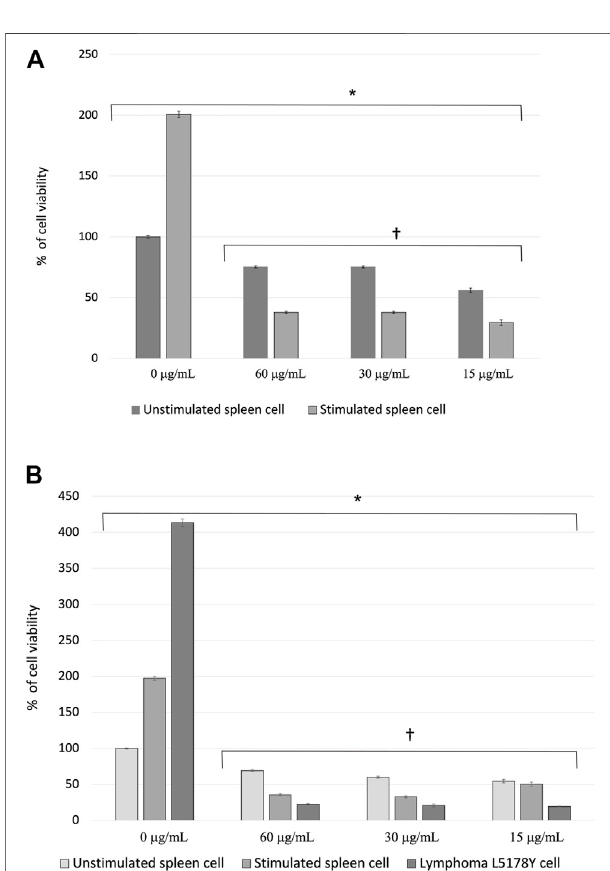
FIGURE 2 | (A) Percentage of cell viability ± standard error of splenocytes of healthy mice stimulated and not stimulated with the mitogen Concanavalin A (ConA) treated with the polar fraction of the ethanolic extract of Lophocereus schottii (µg/mL). Values are the average of % cell viability. *p < 4 X 10 − 4 † p < 2.6 X 10 − 13 . (B) Percentage of cell viability ± standarderrorofsplenocytesfromhealthymicestimulatedandnotstimulated with the mitogen Concanavalin A (ConA) and murine lymphoma L5178Y cells treated with the polar fraction of the ethanolic extract of Lophocereus schottii (µg/mL). *p < 8.9 X 10 − 11 . † p <